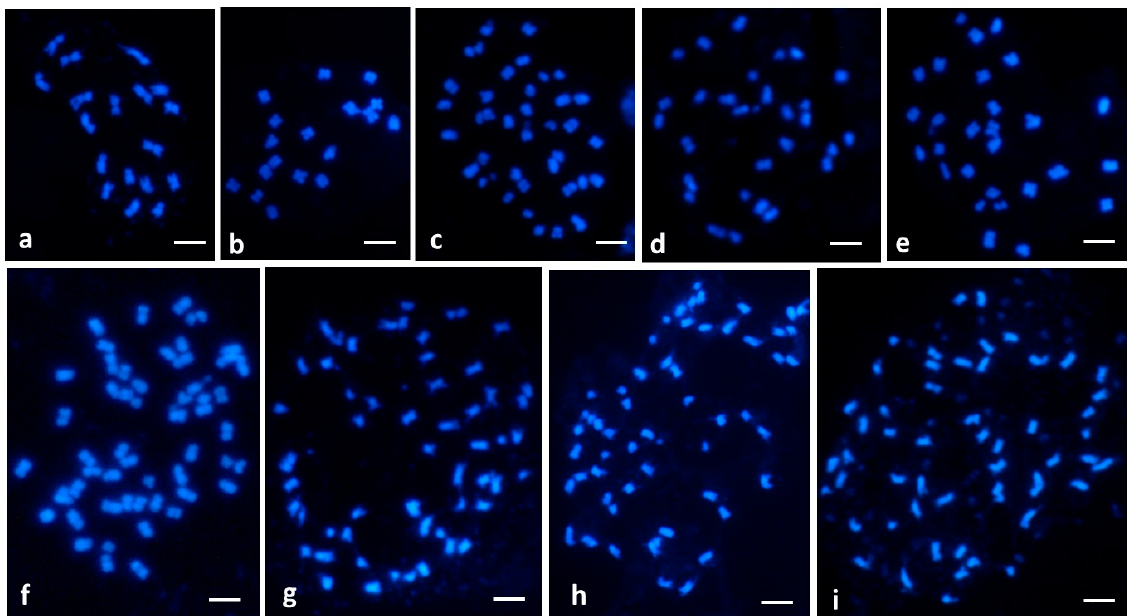
Figure 3. Chromosome counts of Brassica genotypes. ( a ) IW1234 B . oleracea L. var. capitata (head cabbage), 2n = 18; ( b ) IW08 B . oleracea L. var. acephala (kale), 2n = 18; ( c ) RAP62 B . napus (rapeseed), 2n = 38; ( d ) S3 F 1 (head cabbage × rapeseed), 2n = 28; ( e ) S20 F 1 (kale × rapeseed), 2n = 28; ( f ) FS3 F 2 (S3 × S3), 2n = 56; ( g ) FS20 F 2 (S20 × S20), 2n = 55; ( h ) FC320 F 2 (S3 × mixture of pollen), 2n = 55; ( i ) FC230 F 2 (S20 × mixture of pollen), 2n = 55. Scale bars represent 5 μ m.